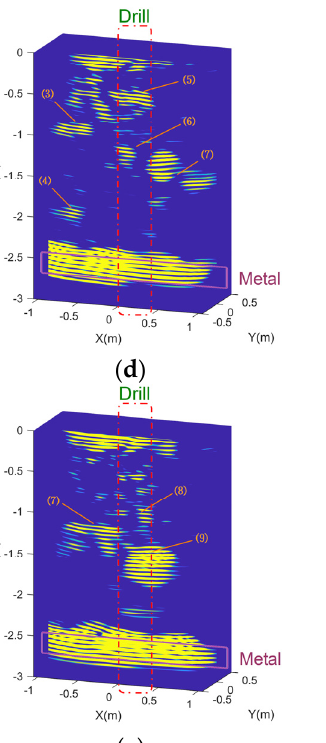
Table 3. Computational Efficiencies of RTM Imaging Methods with Three Schemes.